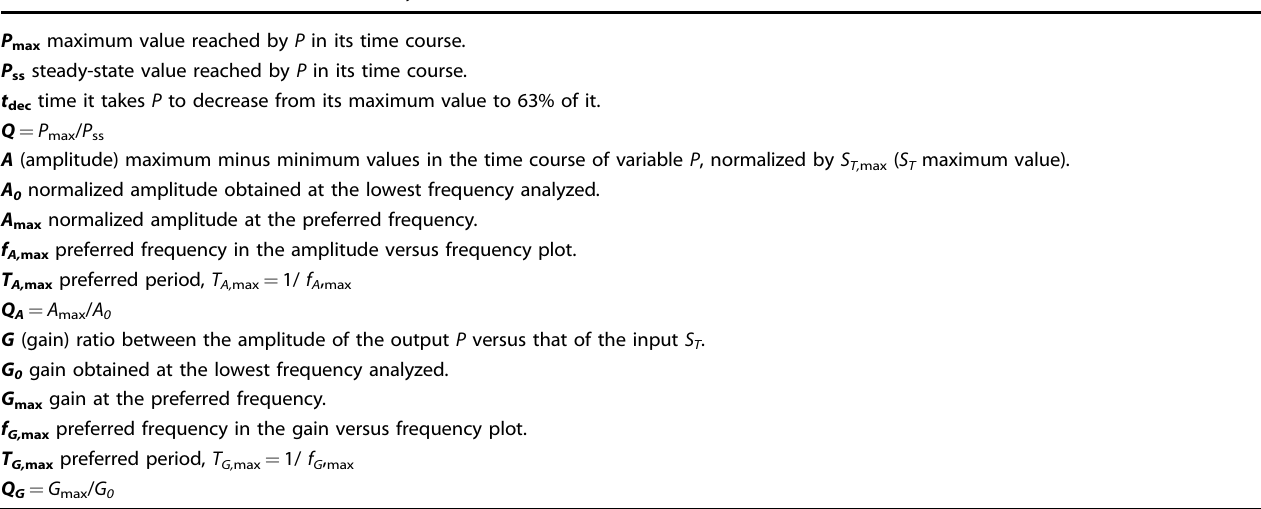
Table 1. List and de fi nitions of attributes analyzed in the